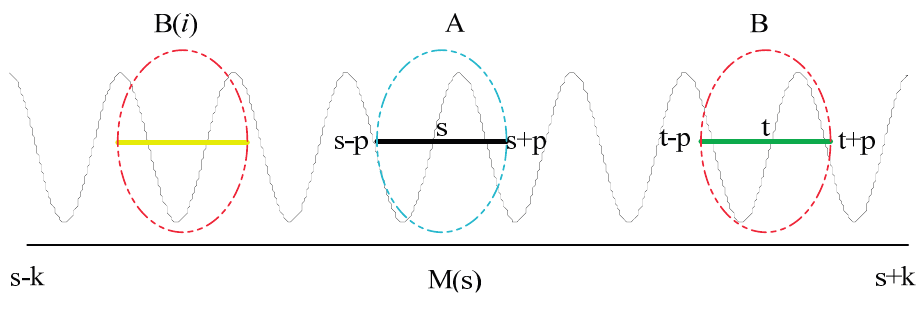
Figure 1. Illustration of NL-means